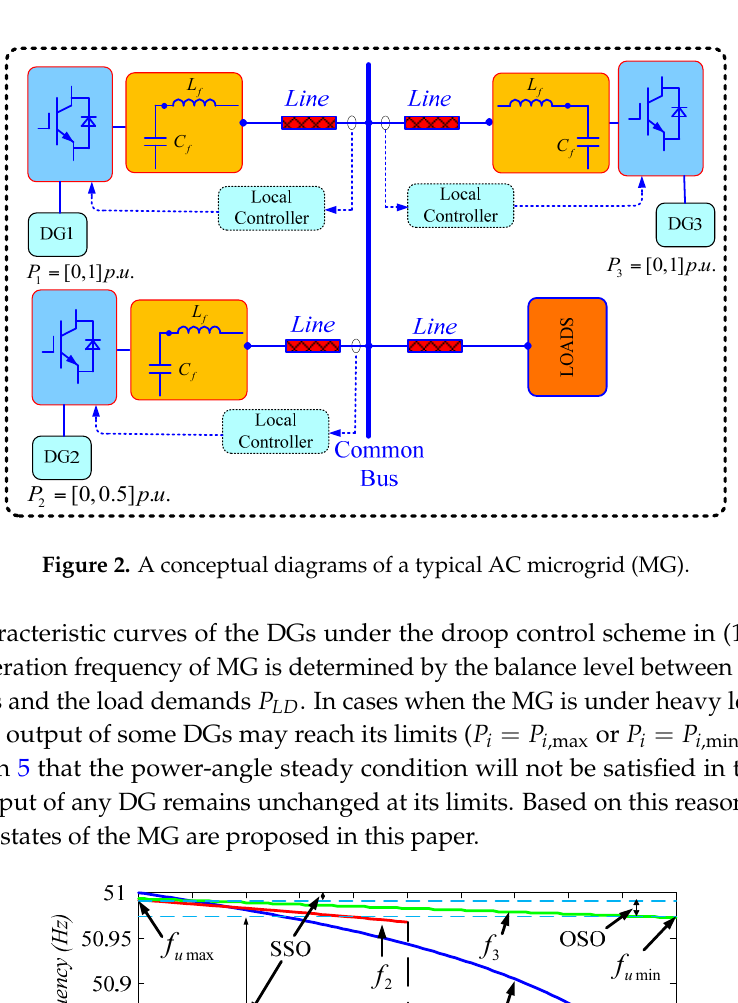
Table 1. Cost coefficients for the considered AC MGs.